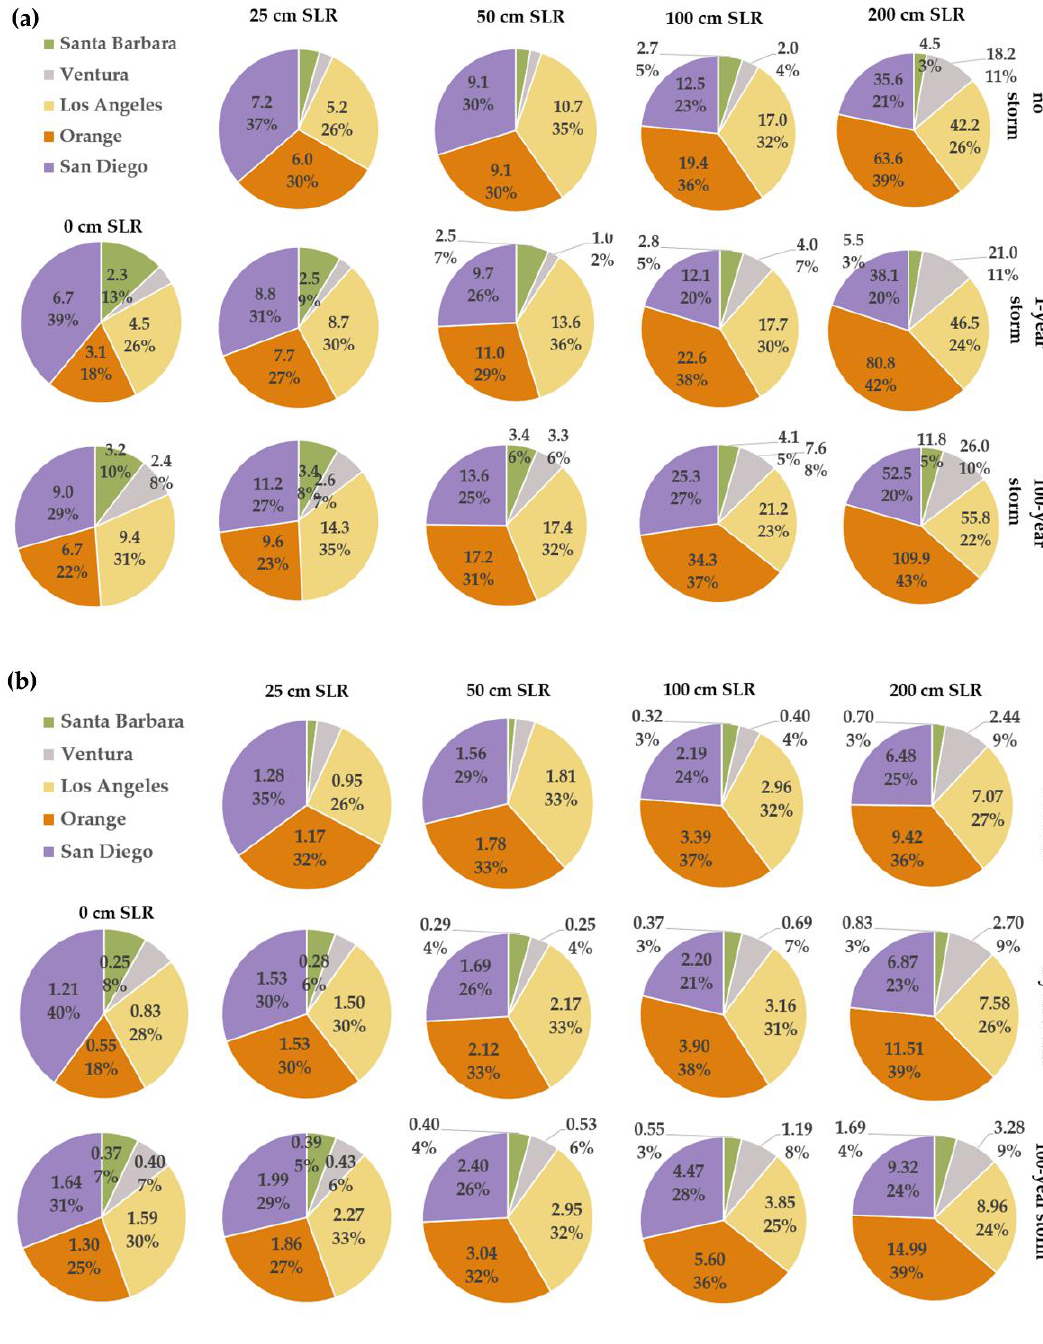
Figure 5. Example of socio-economic impacts resulting from flood hazards modeled for sea-level rise (SLR) scenarios of 25, 50, 100, and 200 cm without storms and in combination the annual and 100-year projected storms. ( a ) County residents (1000) and ( b ) building replacement values in billions of dollars. Pie charts show the proportion of residents affected and cost burdens within each of the five Southern California coastal counties (number of residents, cost of building replacements, and percent of totals with respect to impacts to all of Southern California). Results for the 75, 125, 125, 150, 175, and 500 cm SLR scenarios and 20-year return period storms are not shown but are commensurate with the trends